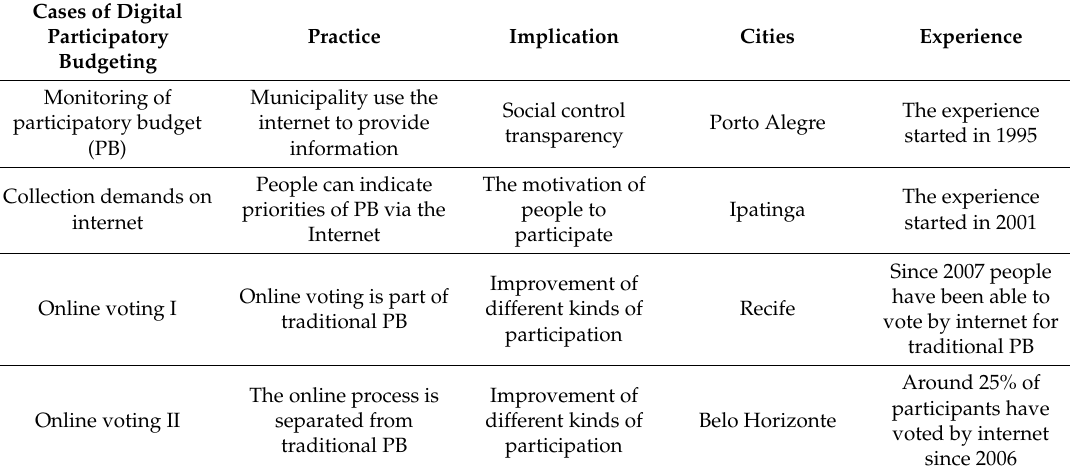
Table 1. Cases of digital participatory budgeting